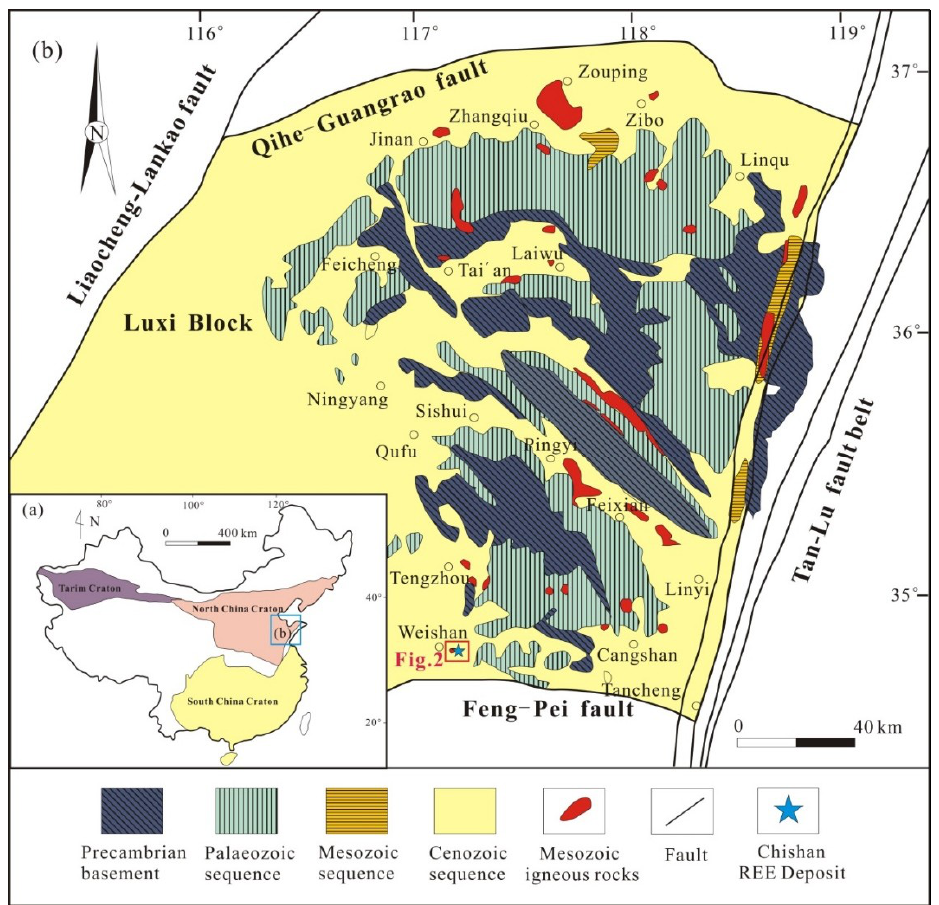
Figure 1. Simplified geological map showing the major tectonic units in China ( a ) and regional geological sketch of Western Shandong ( b ). (a) Geologic and tectonic map of China and the location of Luxi Block, modified after [40]. (b) Geological map of the Luxi Block, modified after [37].